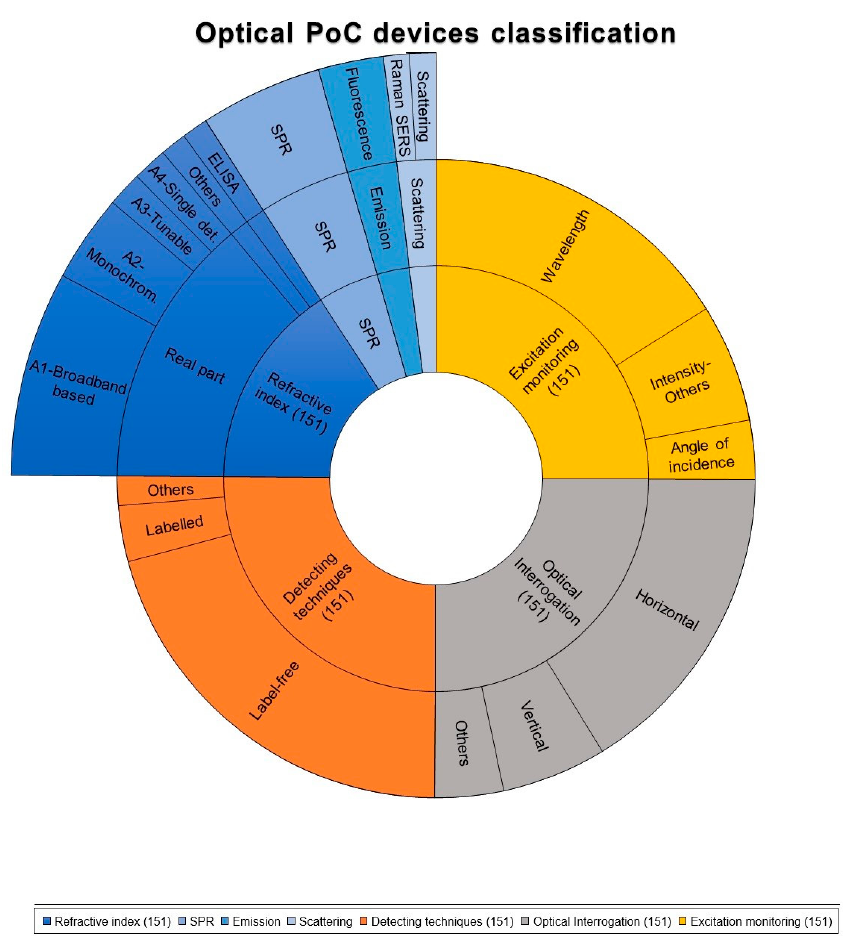
Figure 16. Classification of articles by the categories specified: variations on the refractive index (Real part, Imaginary Part, Emission and Scattering), the optical interrogation technique (Verti- cal/Horizontal), the excitation monitoring (Wavelength/Angel of incidence) and detecting techniques of molecular interactions